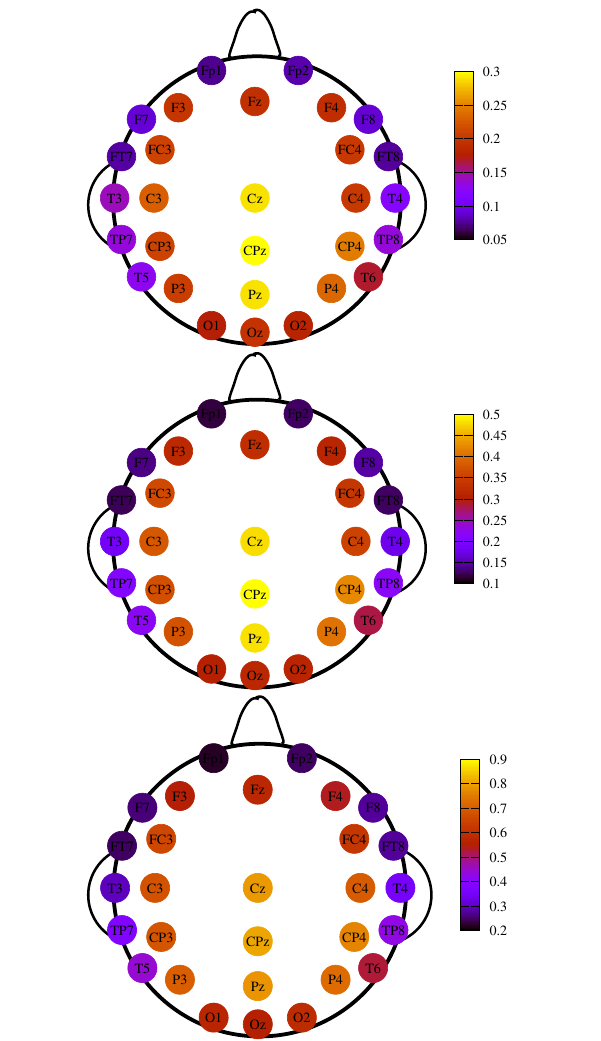
FiGuRE 5 | Topological plots for the relative frequency Π of a channel to be recruited into an avalanche. Top panel: avalanches size is of at least two channels. Middle panel: same for at least four channels. Bottom panel: same for at least 10